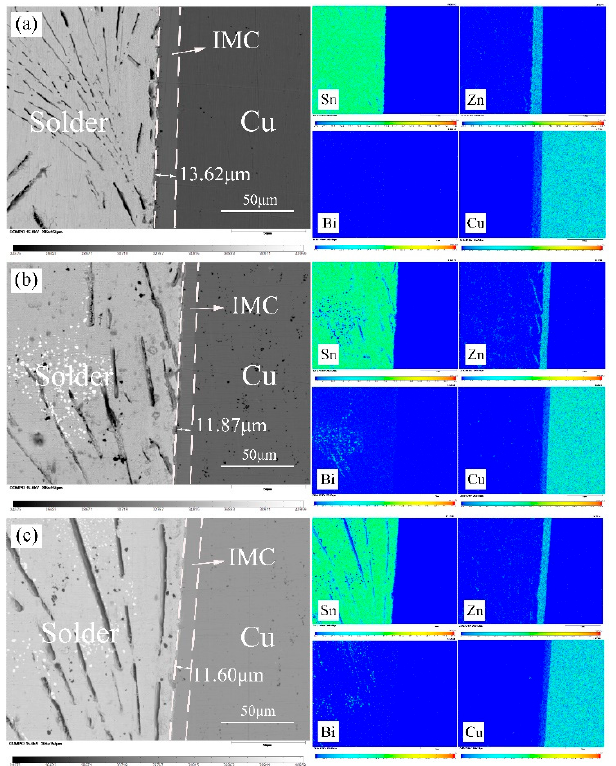
Figure 11. EPMA images and map analyses of the interface of Sn-9Zn-xBi/Cu joints: ( a ) x = 3; ( b ) x = 4; ( c ) x = 5.